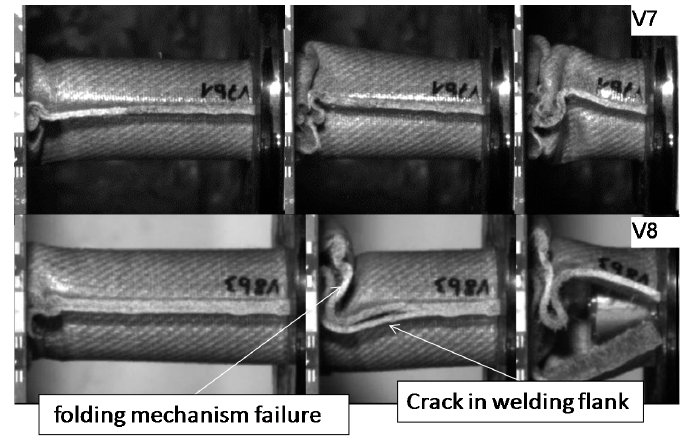
Figure 9. Failure mechanism for V7 and V8 in crash tests series b.